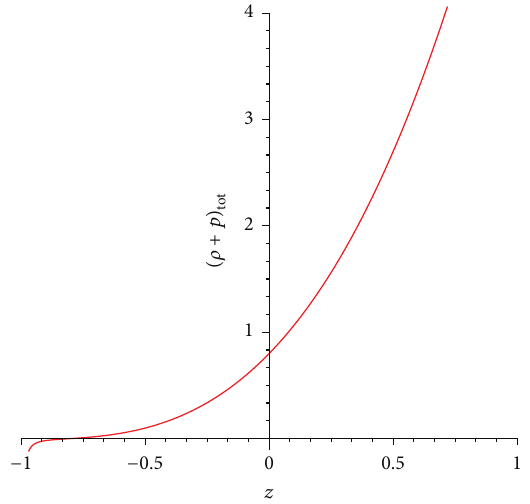
Figure 6: The status of the null energy condition in this